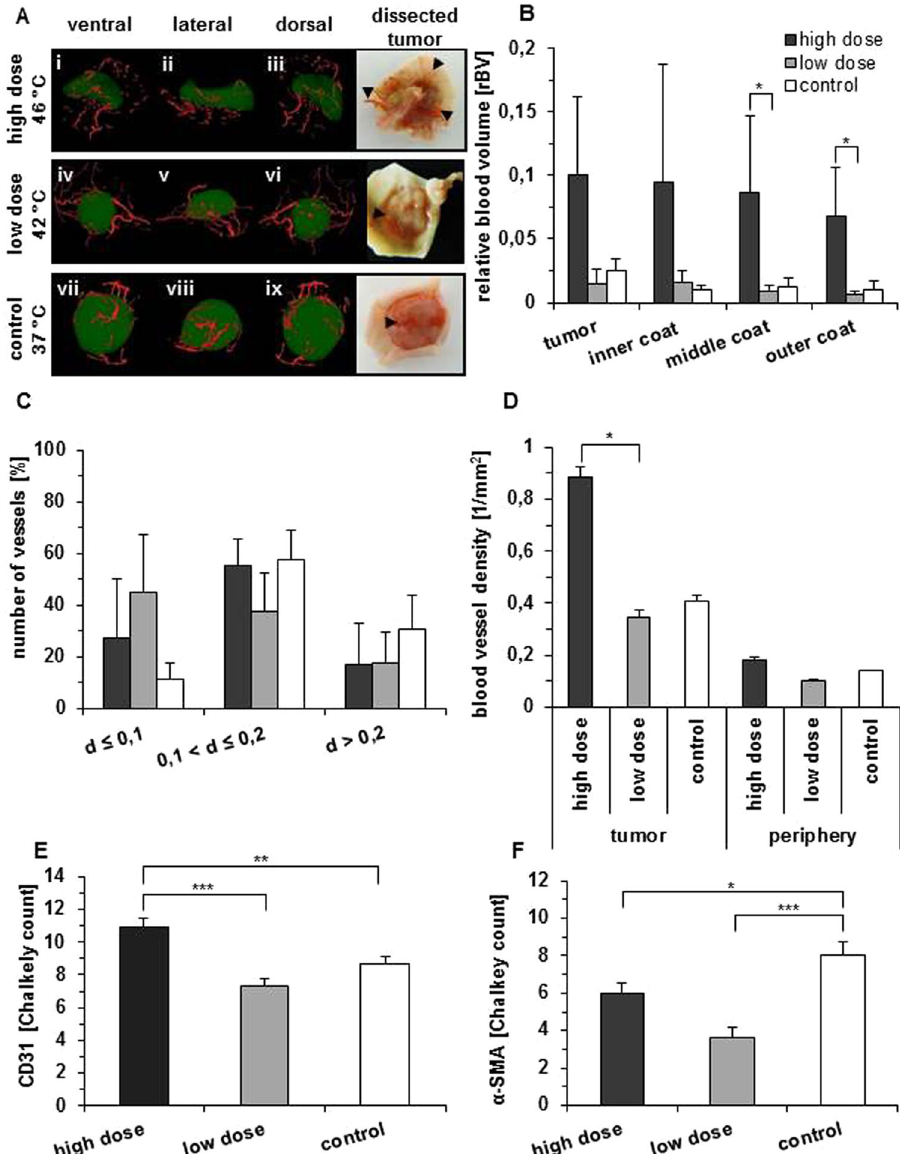
Figure 4. High dose hyperthermia influences the relative blood volume (rBV) and the relative blood vessel density (rBVD) within the tumor and its immediate environment. ( A ) Representative pictures of reconstructed µ CT images. Red: vasculature, green: tumor tissue, arrowheads: vasculature. ( B ) Relative blood volume as estimated by the ratio of vascular volume of three standardized areas that surround the tumor and the tumor itself (for details see Methods). ( C ) Distribution of vessel diameters (d in mm) within the tumor. The number of vessels was related to the tumor volume. We defined three consecutive areas over the tumor surface, whereas each coat has a defined width of 0.592 mm (8 voxel). The total surface area which has been analyzed was of 1.776 mm (24 voxel) (see also Supplementary Fig. 5A and B). The vessel volumes of each area were calculated in proportion to the entire tumor volume. ( D ) Vessel density of the tumor and its periphery. Values were related to the cross sectional area of the tumor or periphery. The number of vessels in a defined field-of-view (FOV) was counted in randomly chosen digital slices of each tumor. The borders of the tumor and of the periphery were chosen to define the different FOV in each of the three planes (see Supplementary Fig. 5C). Therefore, each FOV was related to the respective tumor size. ( E and F ) Quantitative analysis of immunohistochemical staining of CD31 ( E ) or α -SMA ( F ) by Chalkley Count. Data are expressed as means ± SEM. Animals were treated either with low dose (42 °C for 1 h) or high dose hyperthermia (46 °C for 1 h). Controls were not subjected to any hyperthermia treatment. All data refer to 8 days post